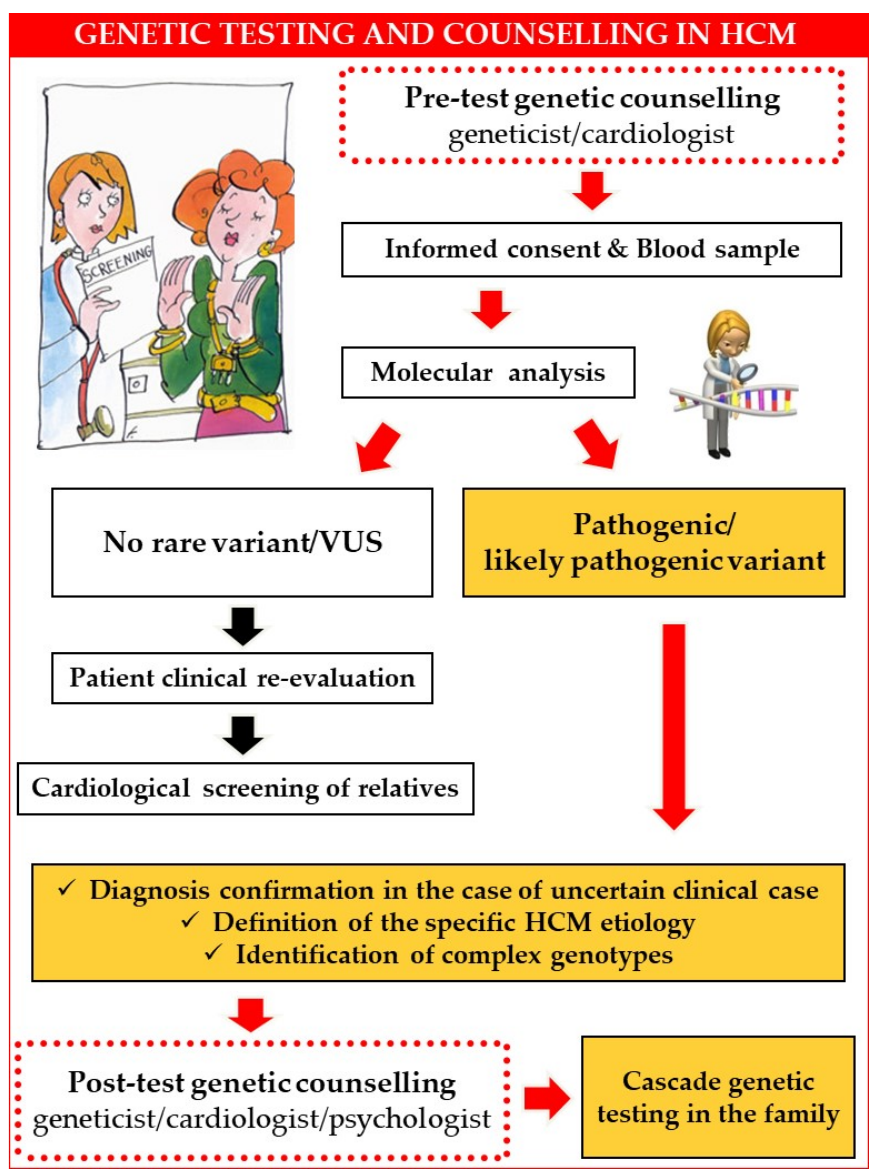
Figure 1 . Genetic testing strategy in HCM. Abbreviations: HCM: hypertrophic cardiomyopathy; VUS: variant of uncertain significance.